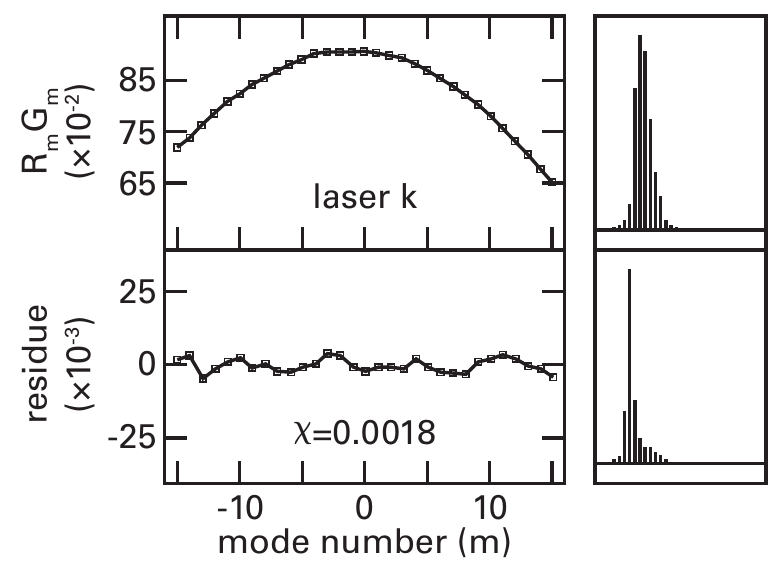
Figure 12. RG product, residue, and worst case above-threshold spectral outputs for a device with a smooth spectral envelope. Adapted with permission from Figure 4 of [37] ©The Optical